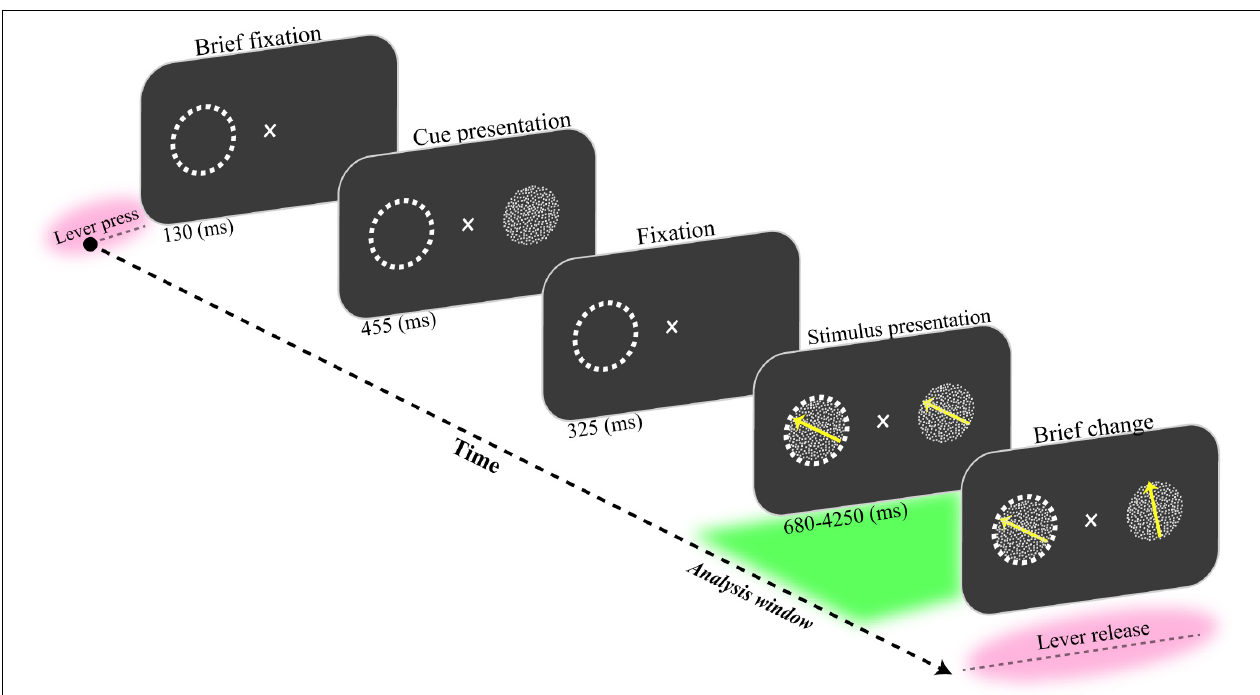
FIGURE 1 | Behavioral paradigm. The monkey had to press a lever while maintaining his gaze on a fixation spot for 130 ms. Then, a static random dot pattern (RDP) appeared for 455 ms to indicate the upcoming target location on the screen. The screen was blanked for the next 325 ms. Next, two RDPs were presented inside and outside the receptive field (marked by a dashed circle here) for a random period of 680 to 4250 ms. The monkey received a drop of juice if it correctly detected a short change in the direction of the target RDP and released the lever within a short time window (150–650 ms). The analysis window was 1500 ms preceding the direction change in the target stimulus (delineated as a green area in the